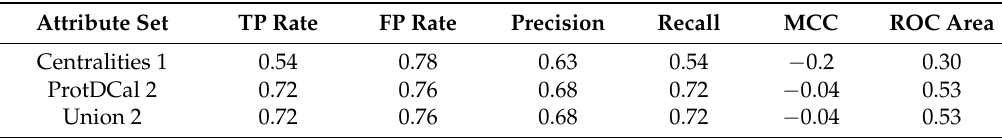
Table 8. Swapped Test for JAMMING3SET Best